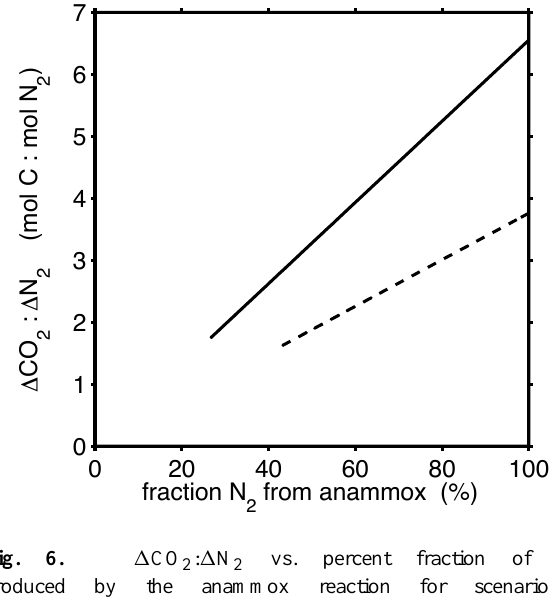
6. 1 CO 2 : 1 N 2 vs. percent fraction of N 2 produced by the anammox reaction for scenario I (DNRN+denitrification+anammox). Solid line is for bulk or- ganic matter compositions, dashed line for